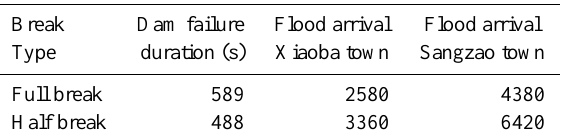
Table 2. Flood arrival time at different locations for the Xiaojiaqiao landslide (Unit: